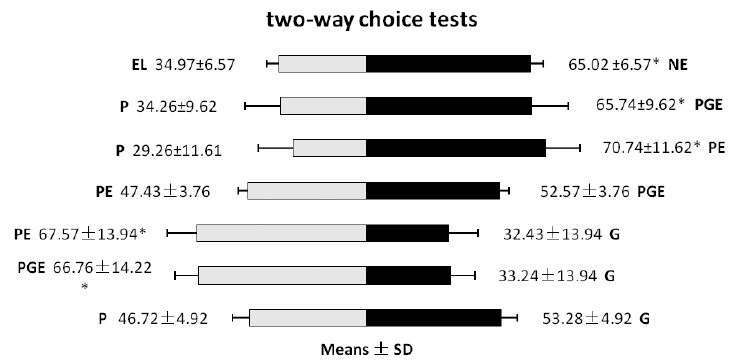
Figure 4. Paired comparison of trend responses of gravid females of Cephalcia chuxiongica to attractive odors P one pine shoot G one gravid female PGE one pine shoot with one female and her fresh eggs on the needles PE one pine shoot with fresh eggs but no female NE needles’ extract EL eggs’ eluent. *Indicates that the trend rate to the odor is statistically significantly higher than that to the other odor in this pair ( P < 0.05, nonparametric Wilcoxon matched pairs test,